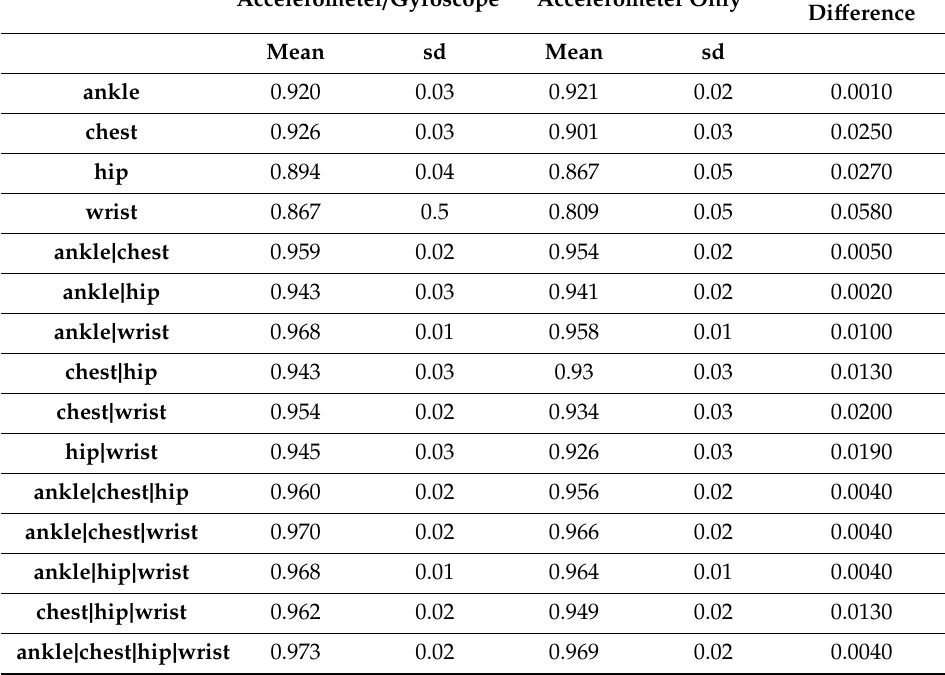
Table 4. Comparison of classification accuracy on the DaLiAc dataset with versus without gyroscope data for all combinations of